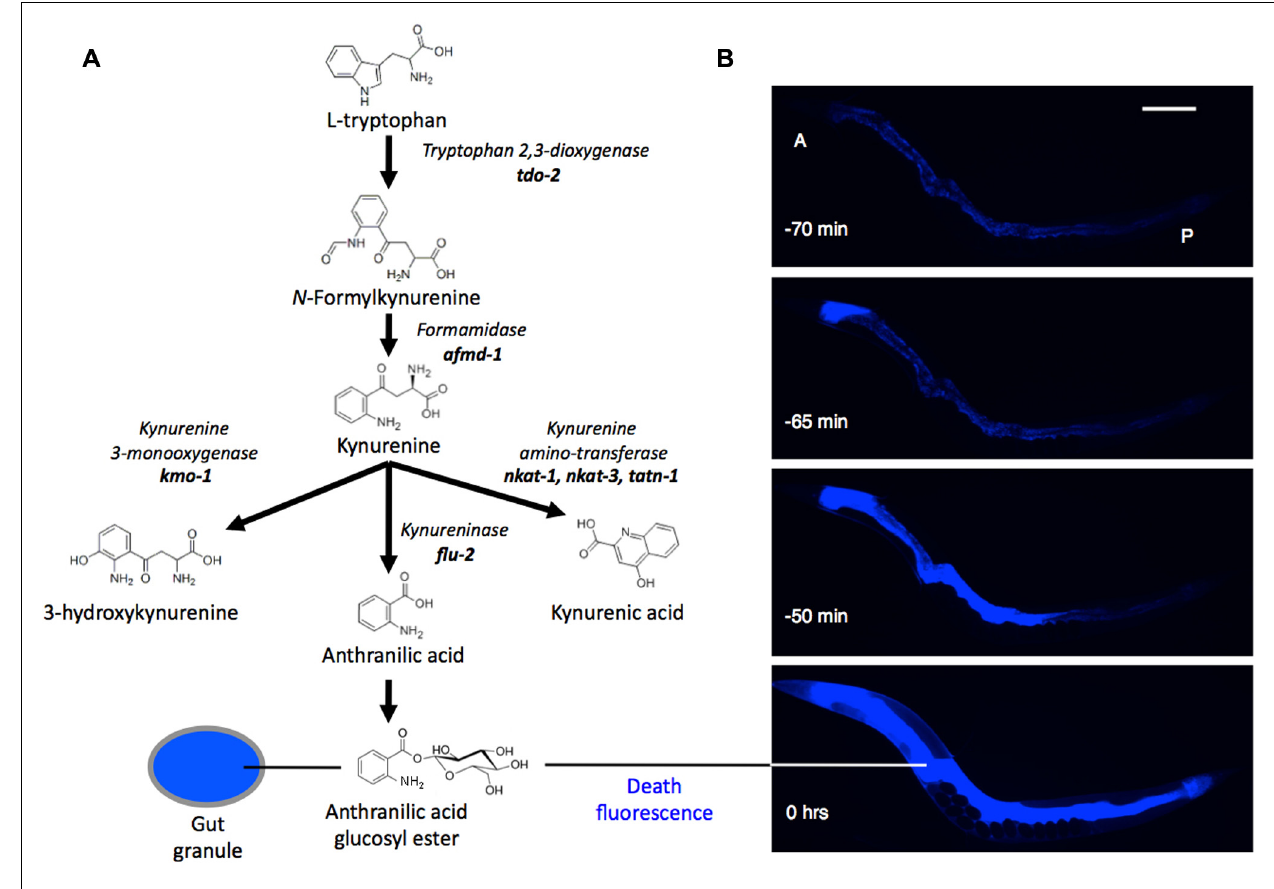
FIGURE 1 | (A) Synthesis of anthranilic acid by the kynurenine pathway. (B) Death fluorescence in young adult C. elegans killed with a heated wire (DAPI filter). During death fluorescence the pattern of fluorescence changes